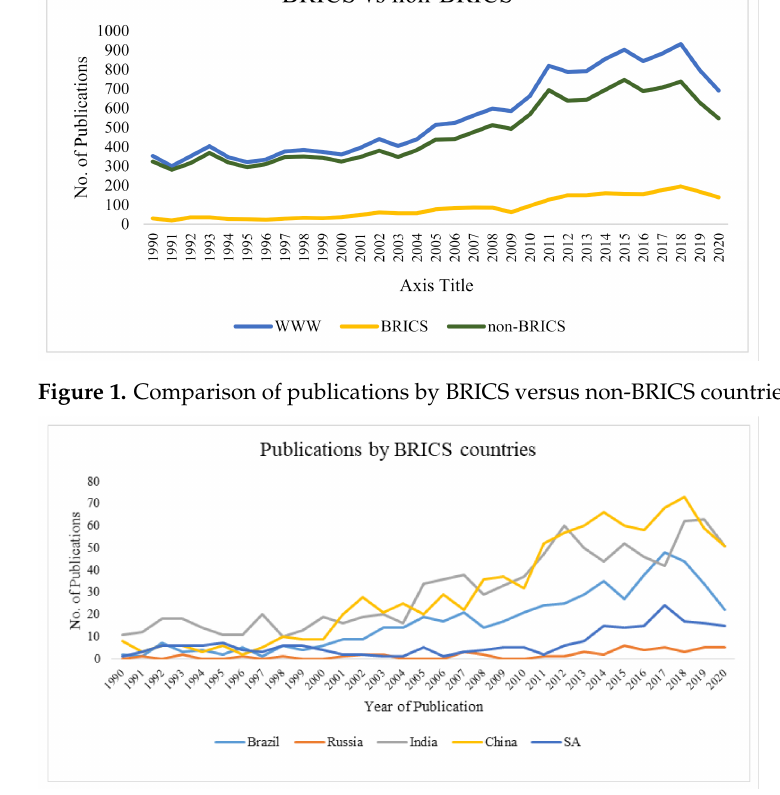
Figure 2. Publication trends by BRICS countries